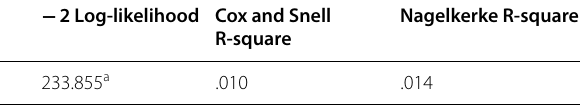
Table F: Model summary for outcome orientation culture